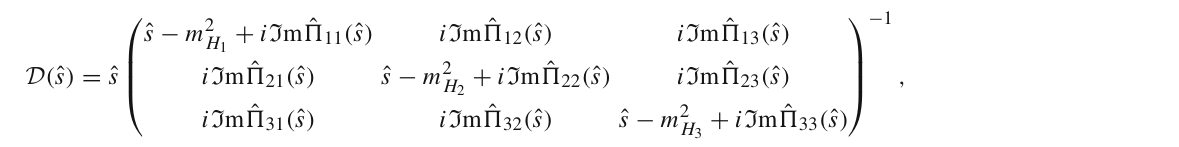
The Higgs-mediated triangle loop diagram